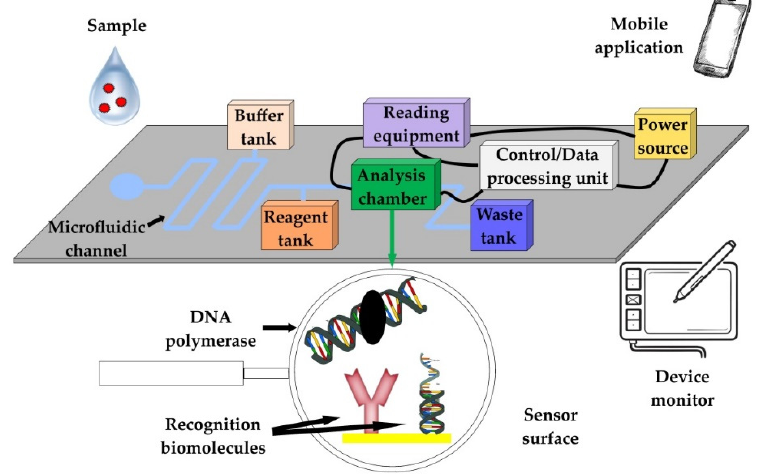
Figure 2. Concept and main components of fully integrated LOC devices. The detection chip (gray parallelogram and analysis chamber) is magnified for demonstration